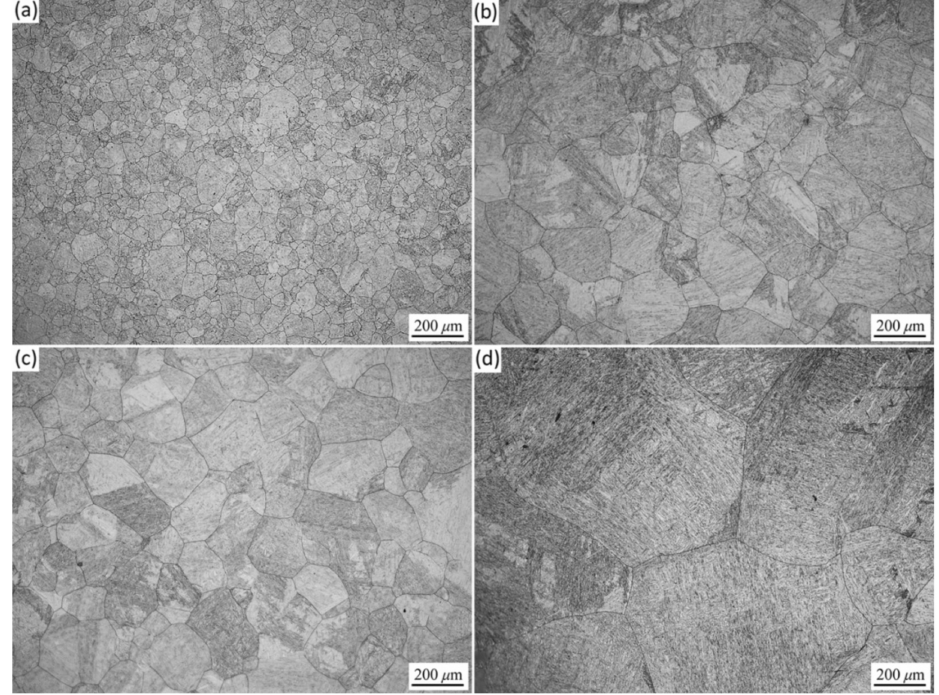
Figure 4. Microstructural evolution of the matrix at different healing times for 60 min: ( a ) 900 ◦ C; ( b ) 1000 ◦ C; ( c ) 1100 ◦ C; and ( d ) 1200 ◦